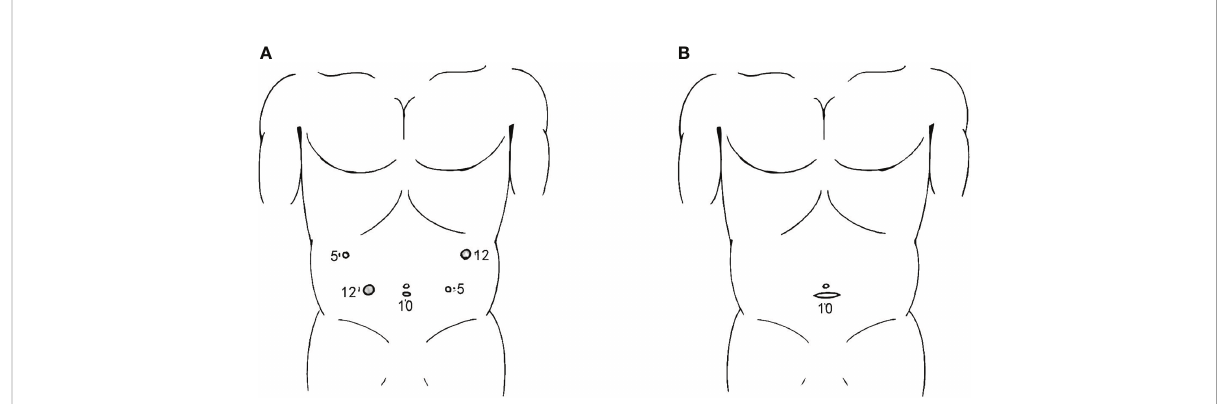
FIGURE 1 Incisions for SPLT-RY in TLDG. (A) Placement of the trocars; (B) abdominal transverse incision used to remove the resected specimen. SPLT-RY, self-pulling and latter transected Roux-en-Y; TLDG, total laparoscopic distal gastrectomy.